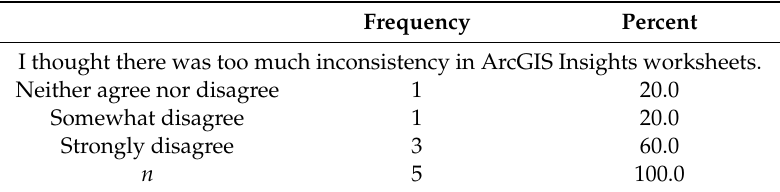
Table 8. Percentages and Frequencies, Q51.